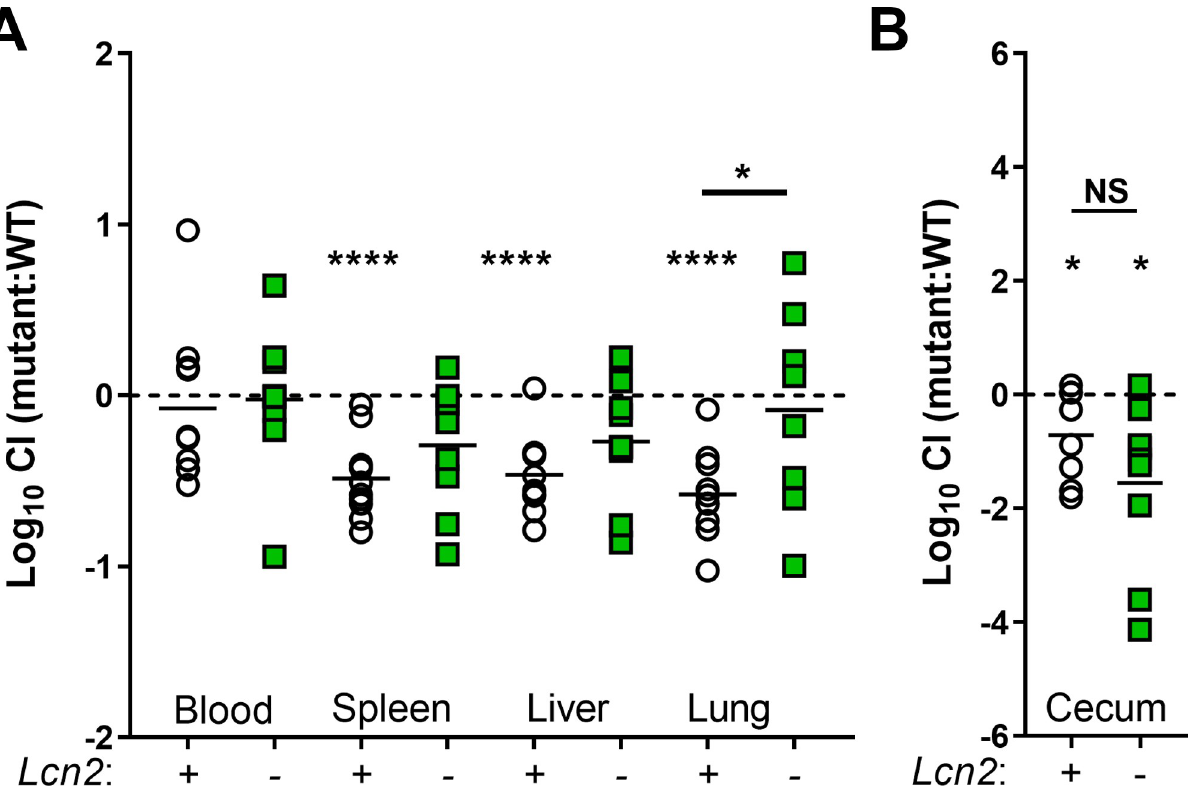
Fig 6. gltA influences site-specific fitness during bacteremia and oral infection. (A) C57BL/6J mice or isogenic Lcn2 -/- mice were intraperitoneally inoculated with approximately 5 × 10 5 CFU of a 1:1 mix of WT KPPR1 and KPPR1 Δ gltA . Bacterial burden in the blood, spleen, liver, and lung was measured after 24 hours, and log 10 competitive index of the mutant strain compared to the WT strain was calculated for each mouse strain (n = 9–11 per group, mean displayed, � P < 0.05, ���� P < 0.00005, one-sample t test or Student’s t test). (B) C57BL/6J mice or isogenic Lcn2 -/- mice were orally inoculated with approximately 5 × 10 6 CFU of a 1:1 mix of WT KPPR1 and KPPR1 Δ gltA . After 48 hours, mice were euthanized, cecum bacterial load was measured, and log 10 competitive index of the mutant strain compared to the WT strain was calculated for each mouse strain (n = 8–9 per group, mean displayed, � P < 0.05, Student’s t